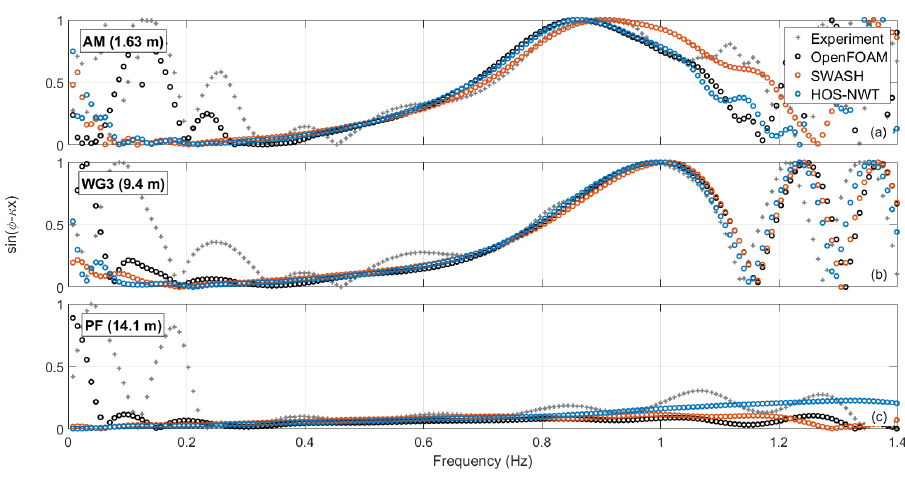
Figure 7. Phases dispersion from AM ( a ), WG3 ( b ), PF ( c ) of the extracted linear harmonics.